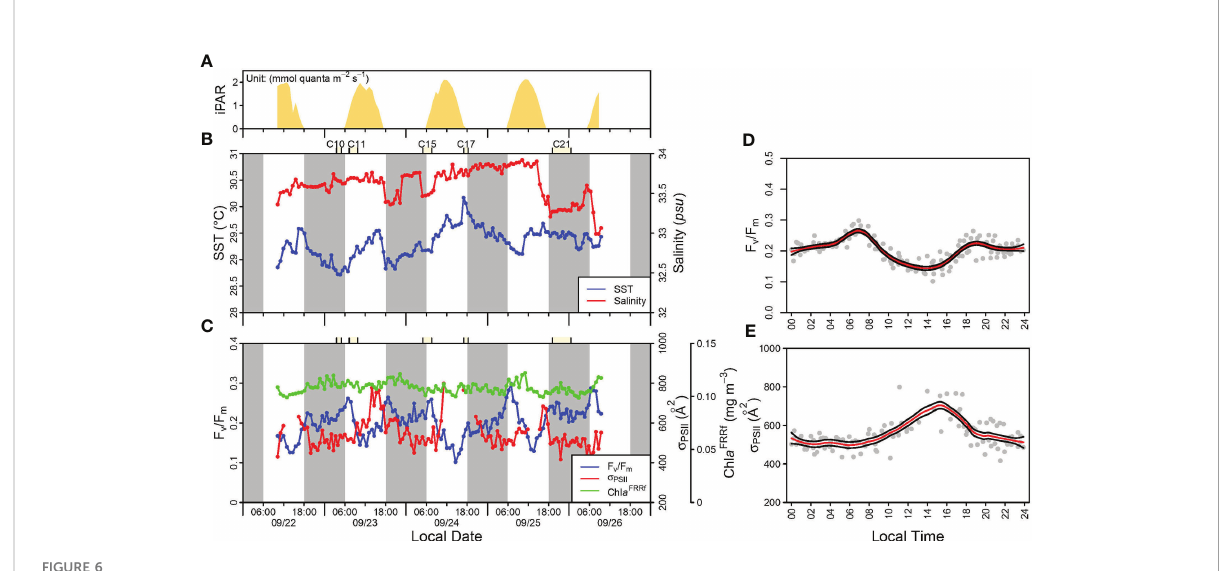
FIGURE 6 Same as Figure 5 but for basin of the northern SCS (Section